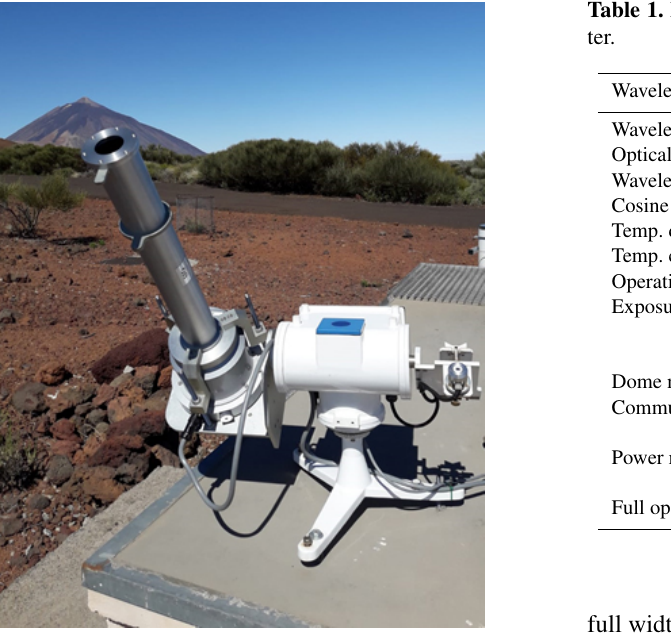
Figure 1. The EKO MS-711 spectroradiometer installed at IZO. ter (IARC) from the State Meteorological Agency of Spain (AEMET; more information at http://izana.aemet.es; last ac- cess: 7 November 2019).